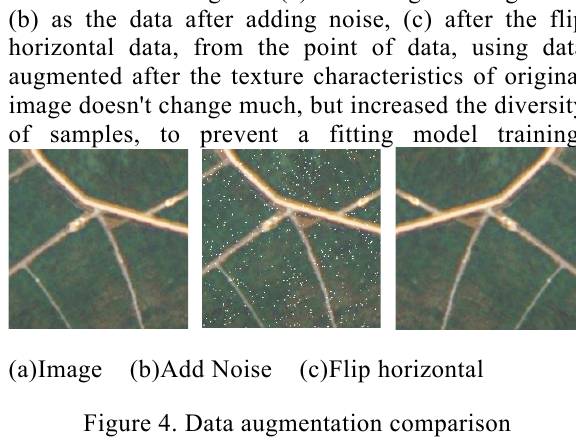
Figure 4. Data augmentation comparison After data enhancement of the original training